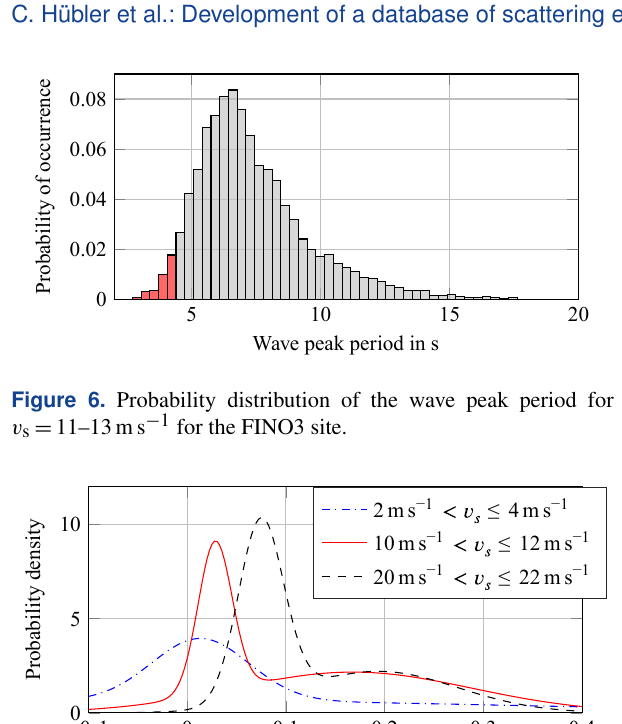
Figure 7. Distribution of the wind shear exponent for different wind speeds for the FINO2 site.